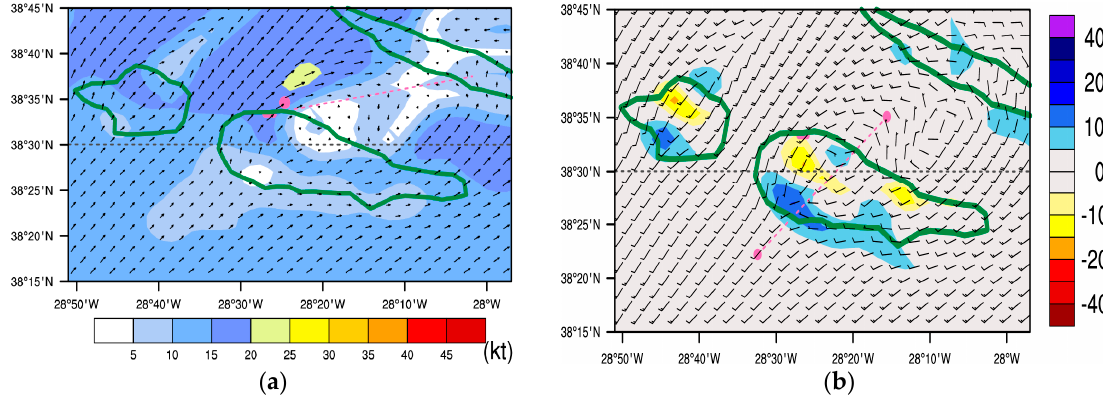
Figure 12. ( a ) Horizontal wind at 135 ft (40 m) for Flight 2.; ( b ) Maximum vertical velocity component under 6000 ft (1829 m) for Flight 2. Both fields are from AROME forecasts. Shading in ( a ) represents the wind speed in kt and the pink dot identifies the approximate aircraft position at this level. Pink dashed line identifies the approximate aircraft trajectory. Shading in ( b ) represents intensity in ft / min, positive values indicate upward vertical velocity and negative values represent downward vertical velocity. The pink dots are the points C and D shown in Figure 2, which are the endpoints of cross-section (dashed pink line) used in the next figures.